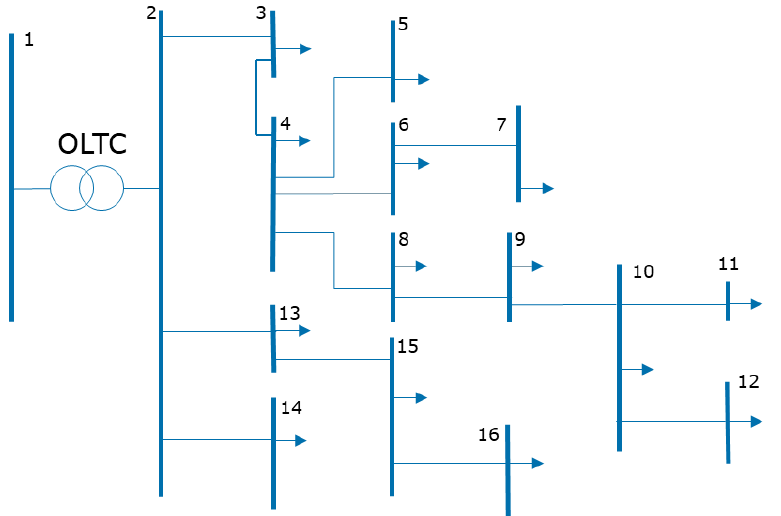
Figure 1. 16-bus UKGDS single-line diagram.